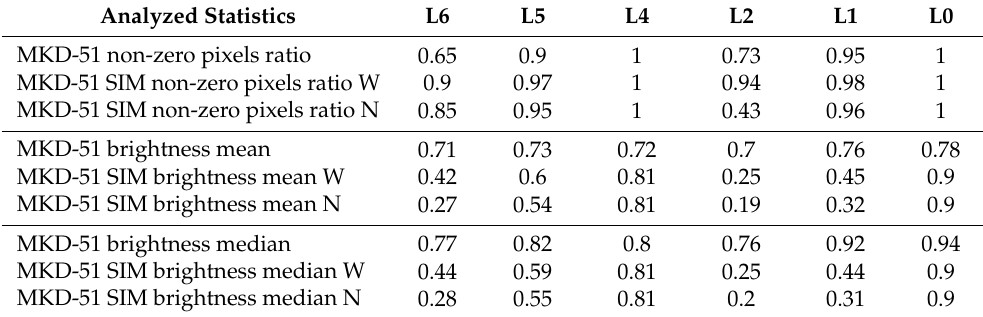
Table 4. Comparison of LED normalized images statistics with (W) and without (N) brightness compensation for 0%, 30%, 60%, and 100% duty cycle of PWM scheme for different photo exposure of the real MKD-51. Analyzed Statistics